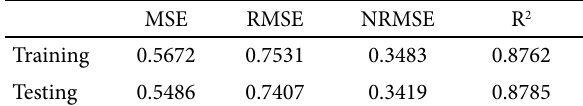
Table 5. The performance of LRM method (scenario